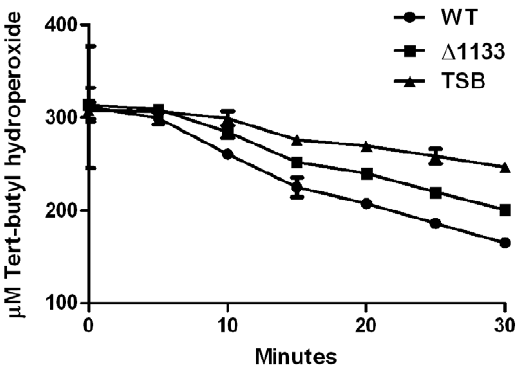
Figure 6. FTN_1133 is required for degradation of an organic hydroperoxide. Three hundred m M tert-butyl hydroperoxide was added to cultures of wild-type F. novicida (circles), the FTN_1133 deletion mutant ( D 1133, squares), or TSB media alone (triangles) and its degradation was measured over time. Data points represent the mean and error bars represent the standard deviation (n=3). Data shown is representative of at least three independent experiments.